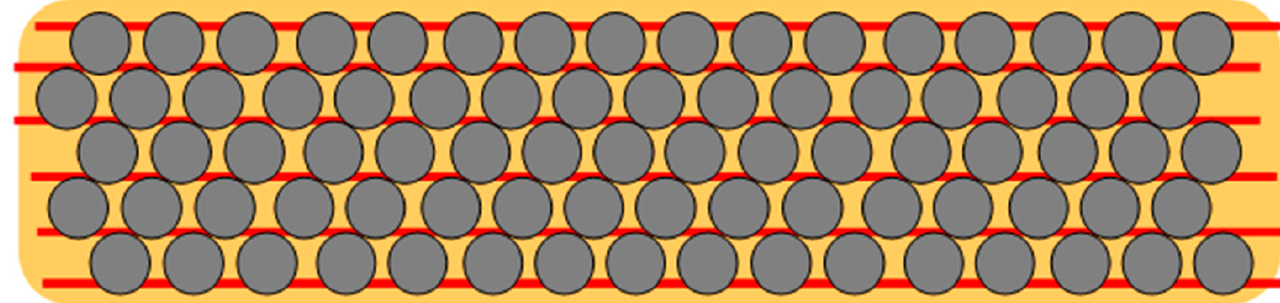
Figure 8. Model for CHM sheet. Illustrated is carbon fiber (CF) (grey) in epoxy (orange) reinforced with CNT fabric (red).